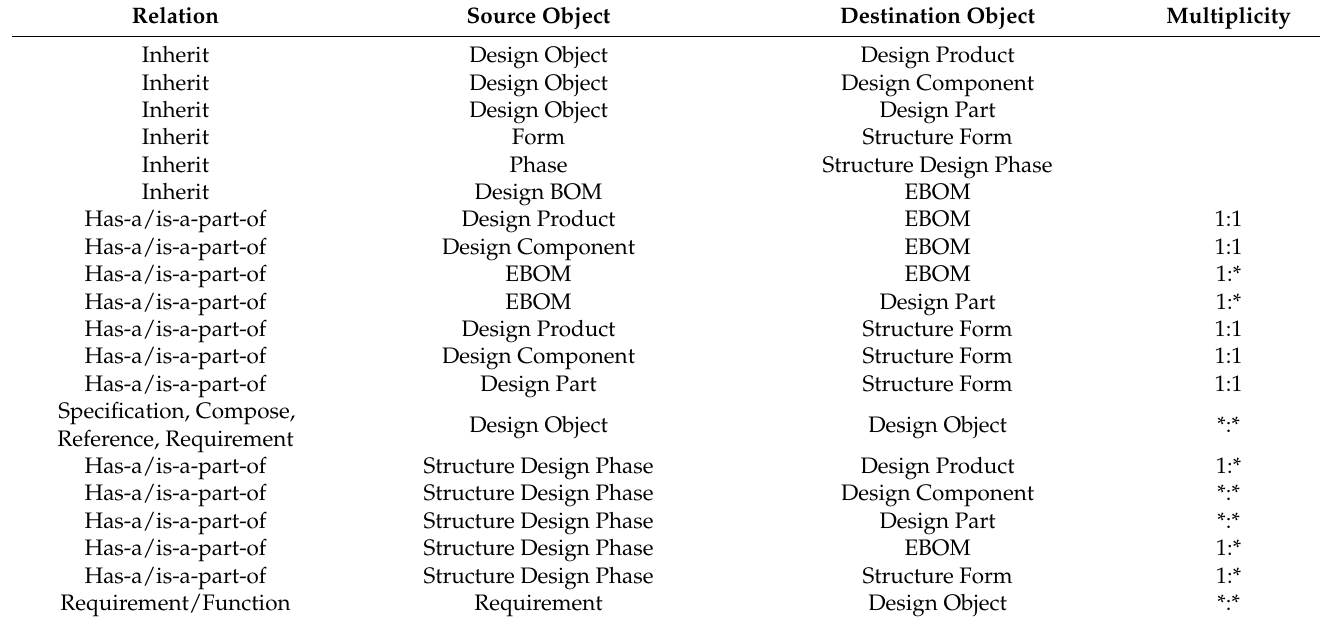
Table 6. Set of rules in the design phase (1, * represent the one and